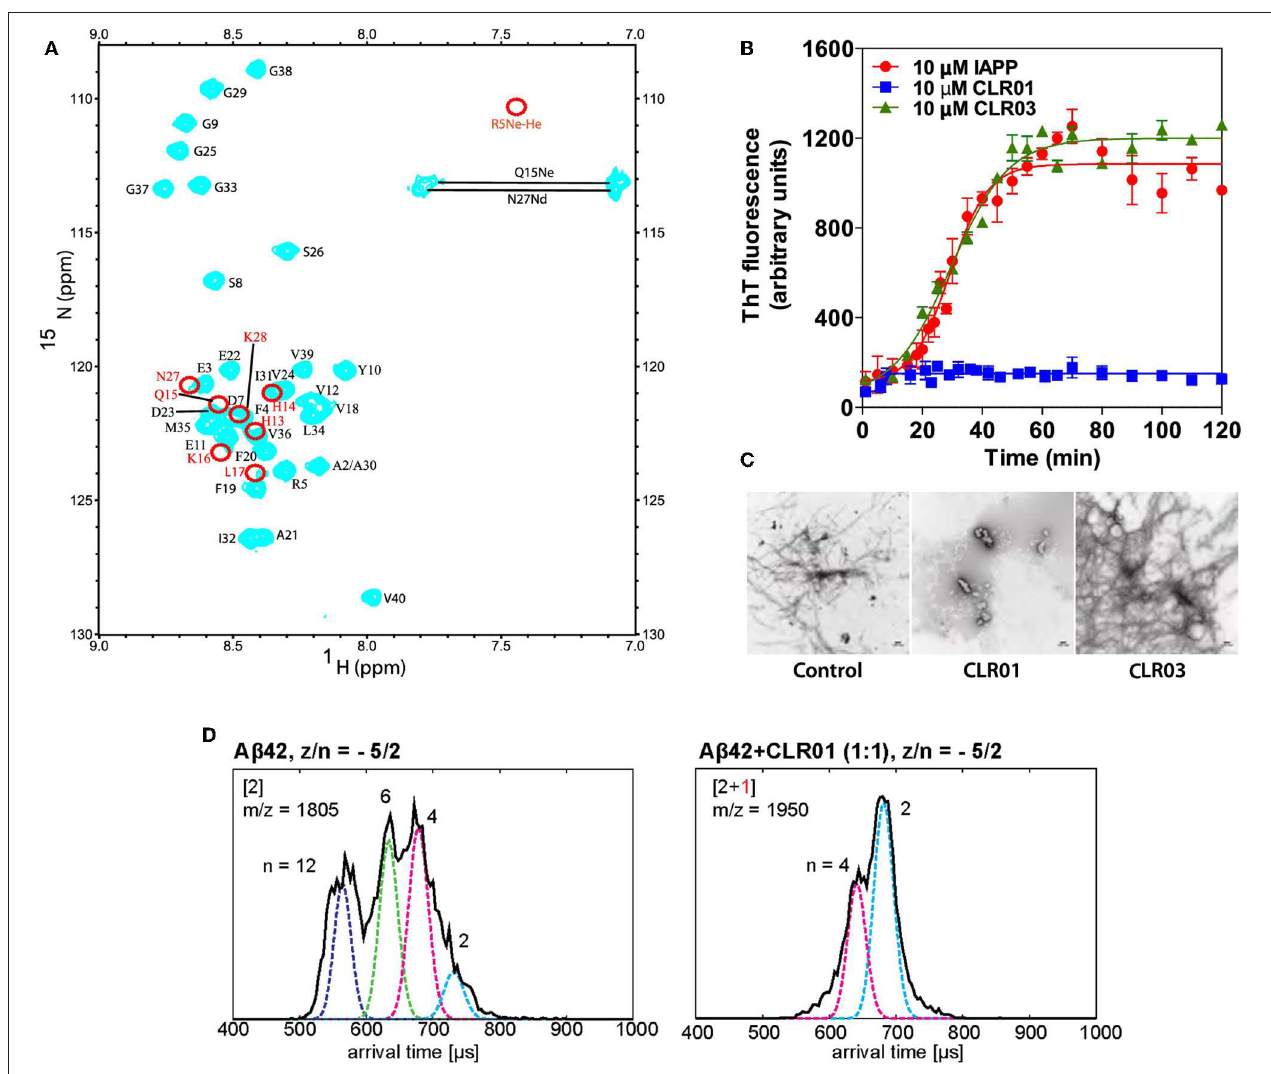
FIGURE 2 | (A) 15 N– 1 H HSQC spectrum of A β 40 in the presence of 30 µ M CLR01 (cyan). Red circles indicate resonances that disappeared completely upon addition of CLR01 to A β 40 solution ( Sinha et al., 2011). (B) Time-dependent ThT fluorescence intensities of incubated solution of: pure IAPP (red); IAPP + CLR01 (1:1) (blue); IAPP + CLR03 (1:1) (green) ( Sinha et al., 2011). (C) EM images of the solutions after titration. CLR01 (middle) clearly shows inhibition of fibril formation (Sinha et al., 2011). (D) Effects CLR01 on A β 42 early oligomerization. Arrival time distributions (by ion-mobility spectrometry) of z/n = − 5/2 A β 42 (m/z = 1805) in an A β 42 sample without CLR01 (left) and z/n = − 5/2 A β 42 and CLR01 1:1-complex (m/z = 1,950). Oligomeric species ( n = 6;12) vanish after CLR01 addition (Zheng et al.,